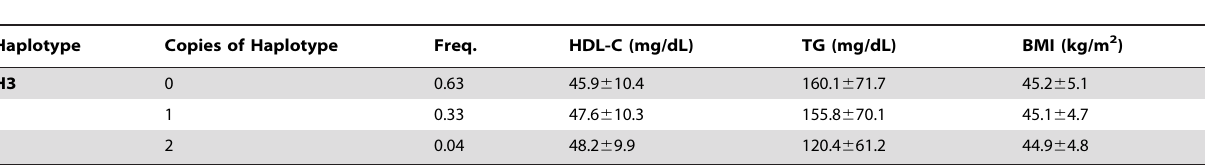
Table 7. Effect of H3 haplocopy on lipid traits (mean 6